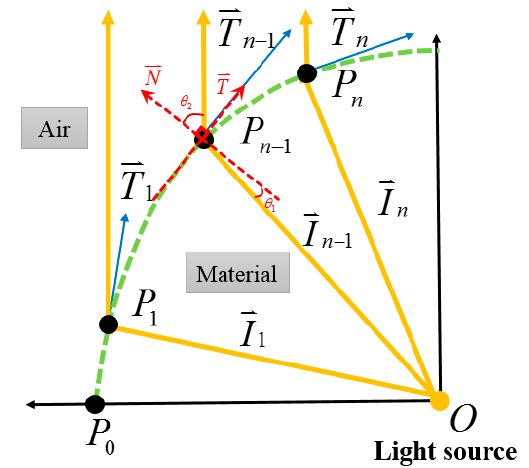
Figure 5. The process for constructing the freeform reflection surface.